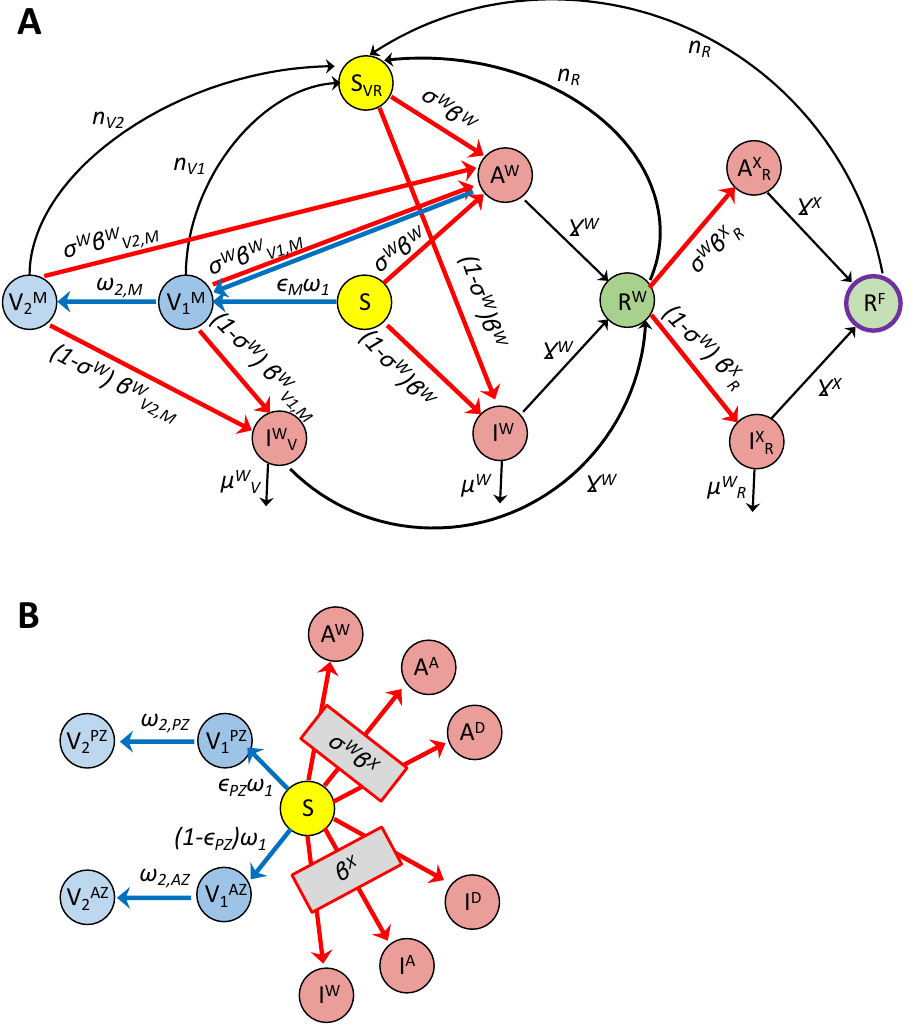
Figure 1. Panel ( A ), schematic diagram for a simplified version of the SV 2 (AIR) 3 model, representing only one virus and one vaccine type. S and S VR , susceptible class; I W , I W V and I W R , symptomatic infected class; A W and A W R , asymptomatic infected class; R W and R F recovered class. Arrows denote the movement from one class to another, via infection (red arrows), vaccination (blue arrows), recovery, or loss of immunity. Rates are indicated on the arrows. β, infection rate; Ɣ , recovery rate; n , rate of immunity loss; μ , death rate; ω , vaccination rate. For a complete definition of the variables, superscripts, and subscripts, see text. In the complete model, three viruses (W = wild type, A = Alpha, D = Delta) and two vaccine types (PZ = Pfizer and AZ = AstraZeneca) are represented. Deaths are indicated only for the symptomatic infected classes, even though natural deaths are represented for all populations. Panel ( B ) shows the full connections associated with the susceptible class S. Arrows indicate movement of S into one of the six infected classes (the A’s and I’s) or one of the two vaccinated classes (V 1 ’s). Movements from one of these infected or vaccinated into another class are not